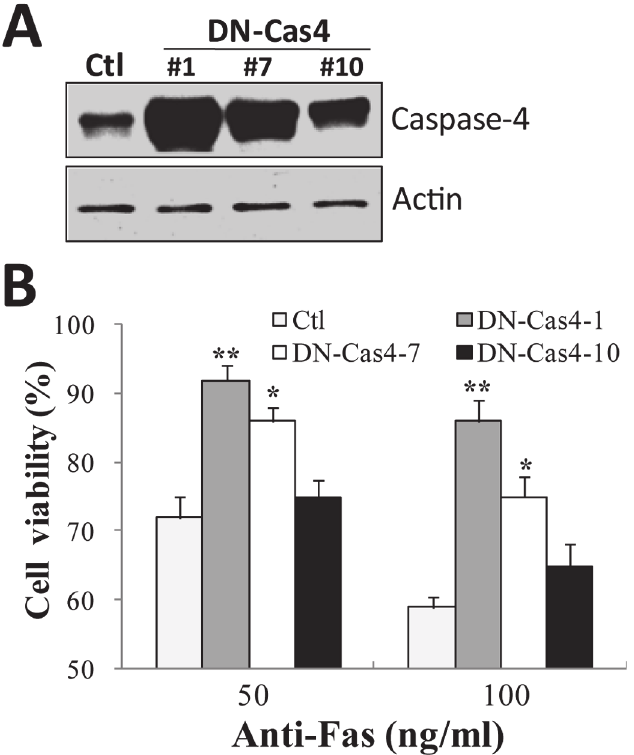
Fig 6. Caspase-4 is required for Fas-induced neuroblastoma cell apoptosis. ( A ) SH-EP1 cells transfected with control vector (Ctl) or DN-Cas4 expression vector (DN-Cas4) were subjected to Western blotting analysis with anti-caspase-4 antibody. #1, #7, and #10 represent selected single cell clones with different levels of overexpression of DN-Cas4.Membranes were re-probed with β -actin as a loading control. Results are representative of three experiments. ( B ) DN-Cas4 cells were treated with anti-Fas antibody of different concentrations for 1 d, and cell viability was examined using crystal violet staining. * P < 0.05 and ** P <